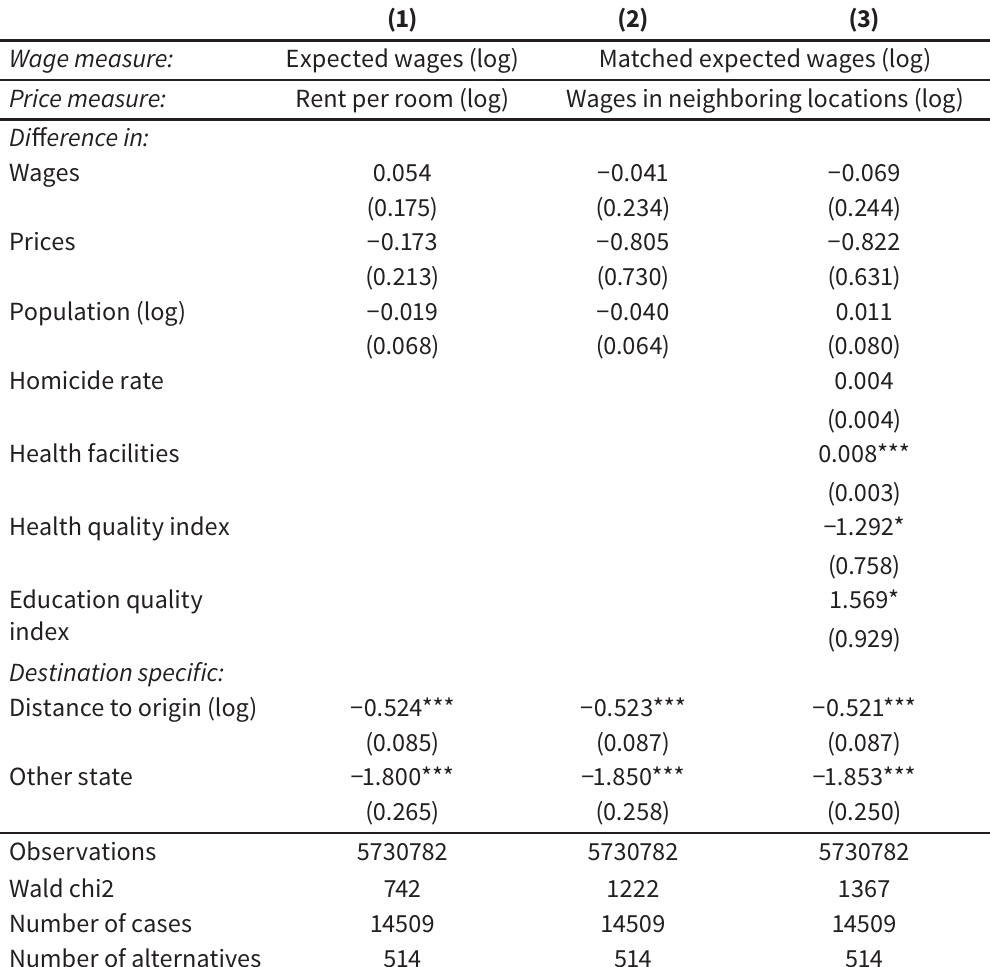
Destination choice conditional on migration, alternative specific logit (1) (2)